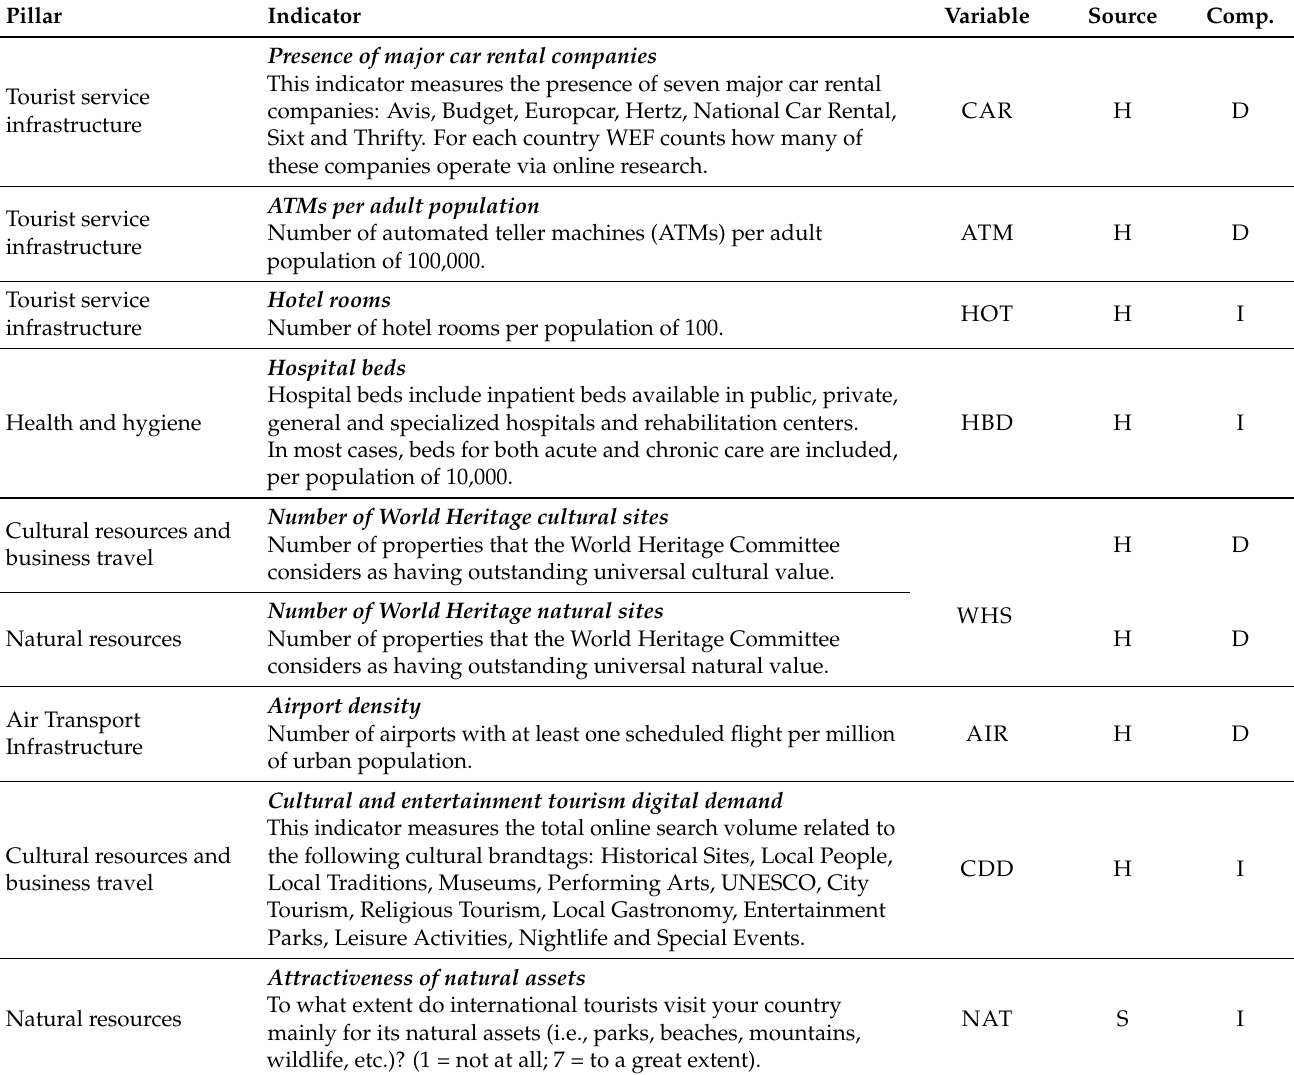
Table 1. Tourism competitiveness variables. Source for indicators can be (S)urvey or (H)ard data. Indicators can be computed (D)irectly or (I)ndirectly from OSM data. Pillar Indicator